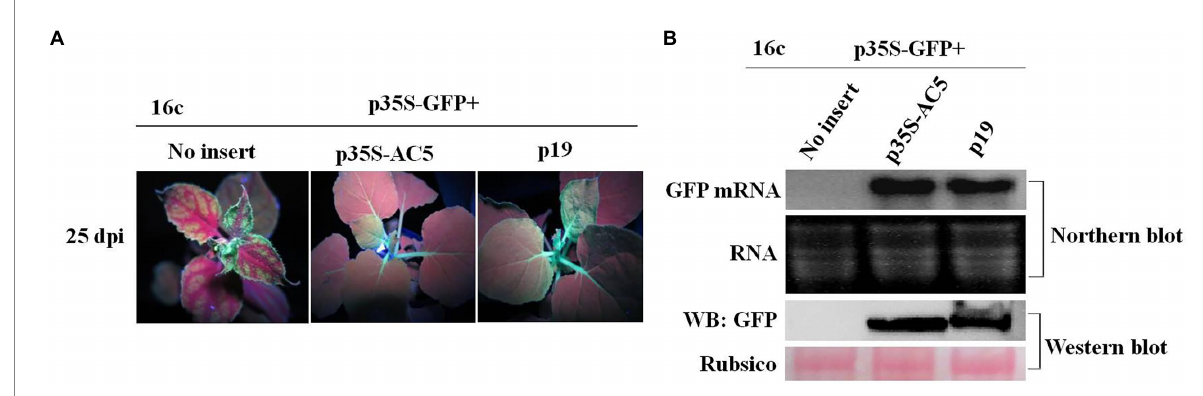
FIGURE 5 The effect of SLCCNV AC5 on suppressing systemic RNA silencing. (A) GFP-transgenic 16c plants were used to determine systemic silencing at 25 dpi. The GFP-transgenic 16c plants co-infiltrated at the seven-leaf stage with the mixture of carrying p35S-GFP, vector, p35S-AC5 expressing vectors or p19 were observed. (B) Northern blot analysis of GFP mRNA and western blot analyses of GFP, RNA, and proteins isolated from the systemic leaves at 25 dpi. SYBR Safe DNA Gel staining of rRNA and Ponceau S staining of the subunit of Rubisco served as loading